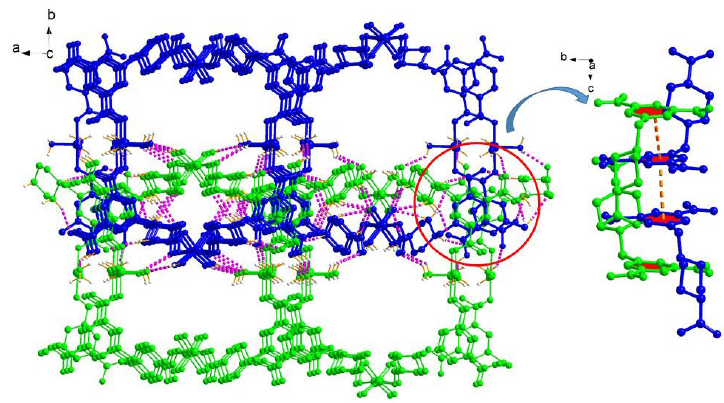
Figure 4. The 3D framework of 1 packed by hydrogen bonds and π - π stacking interactions.